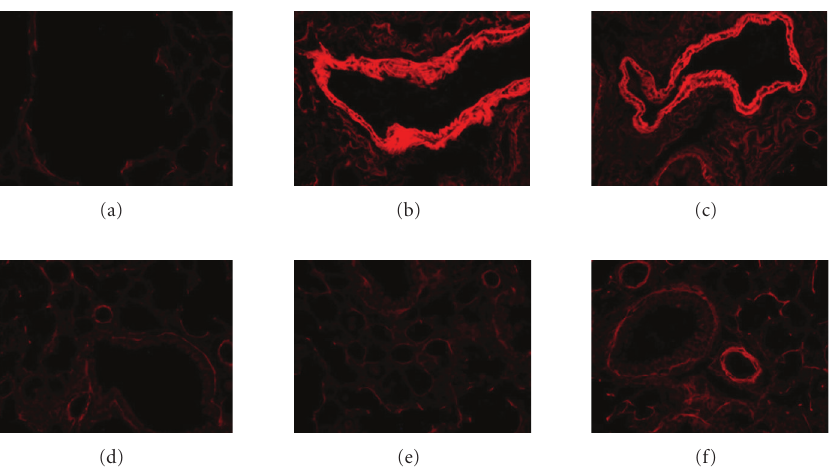
Figure 3: E ff ect of RAE on immunohistochemistry of lung tissue (Congo red stain) in lung tissues of OVA-induced asthma murine ((a): nor- mal C57bl/6 mice; (b) and (c): OVA-induced asthma mice (control); (d): OVA-induced asthma mice treated with cyclosporine A (10mg/kg); (e): OVA-induced asthma mice treated with RAE (450 mg/kg); (f): OVA-induced asthma mice treated with RAE (45mg/kg)).